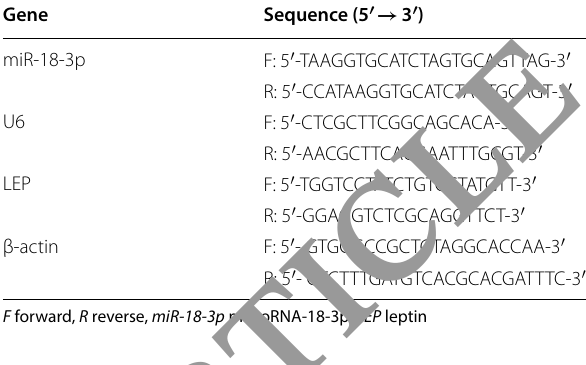
F forward, R reverse, miR-18-3p microRNA-18-3p, LEP